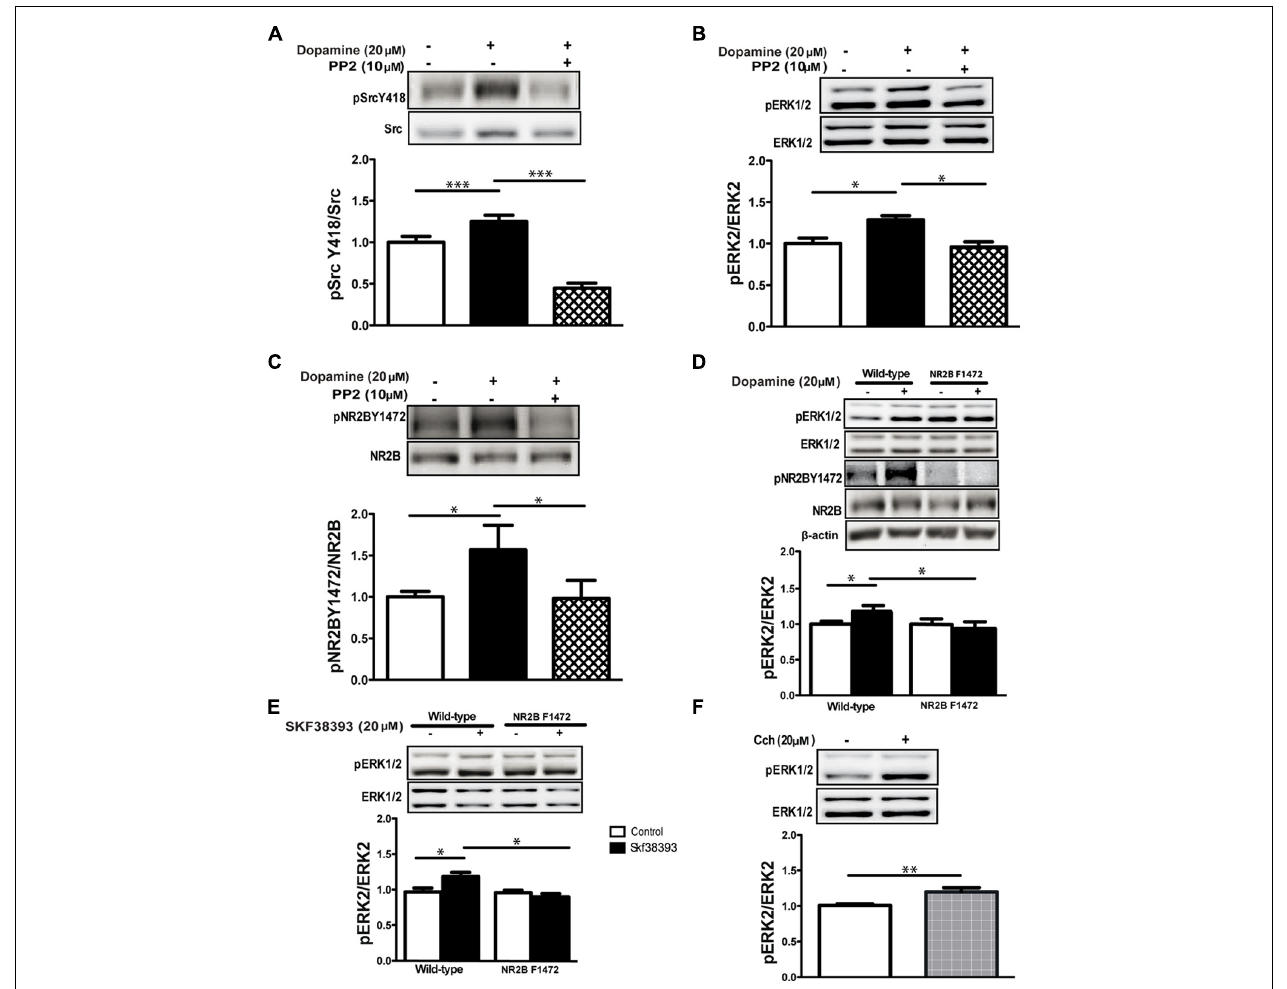
FIGURE 3 | Dopamine-induced NR2B Y1472 phosphorylation by SFKs is necessary for ERK activation. (A) Dopamine (20 μ M, 10 min) increases phosphorylation levels of Src Y418 (*** p < 0.001 vs. control, n = 6), (B) pERK1/2 (* p < 0.05 vs. control, n = 6), (C) NR2B Y1472 (* p < 0.05 vs. control, n = 6) in C57BL/6 mice hippocampal slices. PP2 (10 μ M) prevents these dopamine-induced increases in phosphorylation levels ( n = 10). (D) Dopamine-induced elevation of phosphorylation of ERK1/2 is